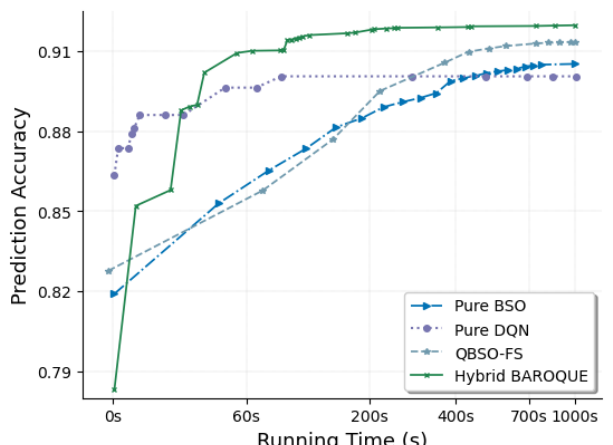
Figure 4. The prediction accuracies of four algorithms, BSO, DQN, BAROQUE, and QBSO-FS, over time based on the 102 features extracted from the three-axis accelerometer and three-axis gyroscope sensor data in the evaluation set from the SMT dataset.